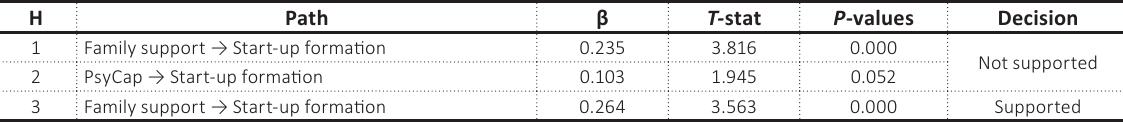
Table 3. Structural model estimates – mediating